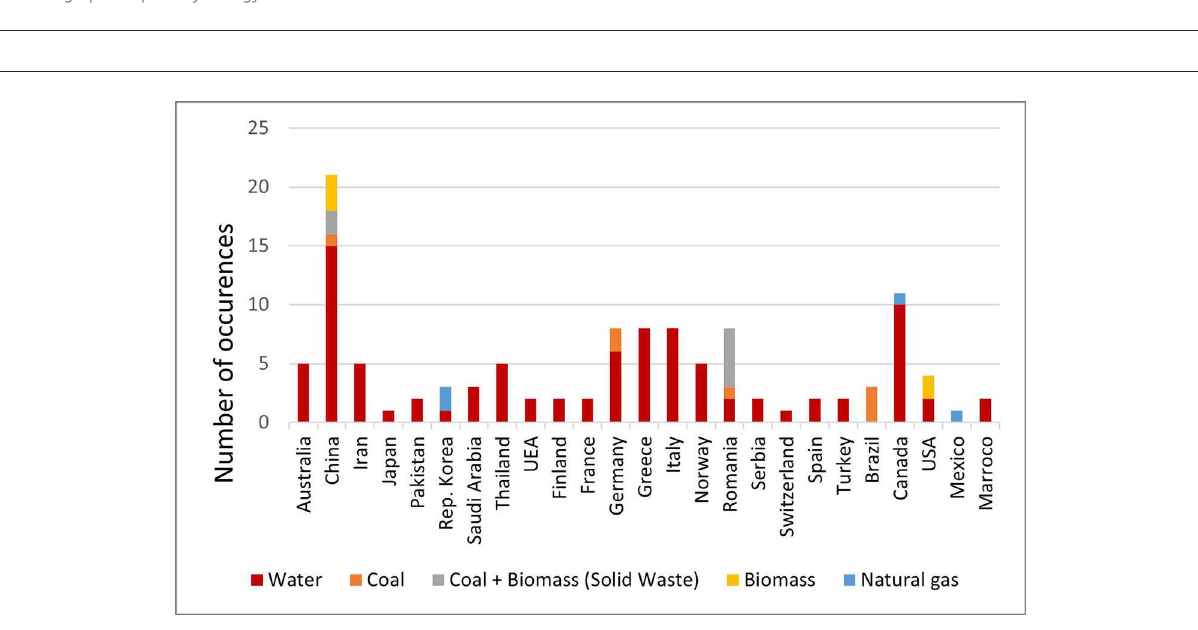
FIGURE4 Hydrogen feedstock of various